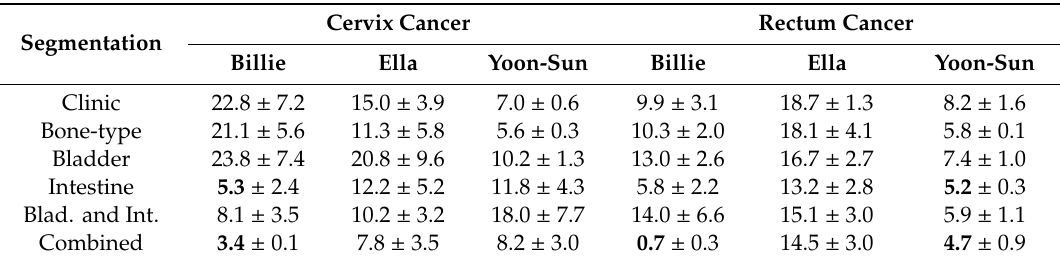
Table 3. The impact of di ff erent segmentation on the simulated hyperthermia dose within females. This was quantified in the absolute value of the relative di ff erence in THQ ( | dTHQ | ). Note that the evaluation for each model and segmentation was the maximum between the three di ff erent sizes. | dTHQ | values approximately equal and below 5%, i.e., the threshold for clinical relevance (~0.2 ◦ C), are given in boldface. For each cancer type and model, maximum values and their standard deviation are listed.